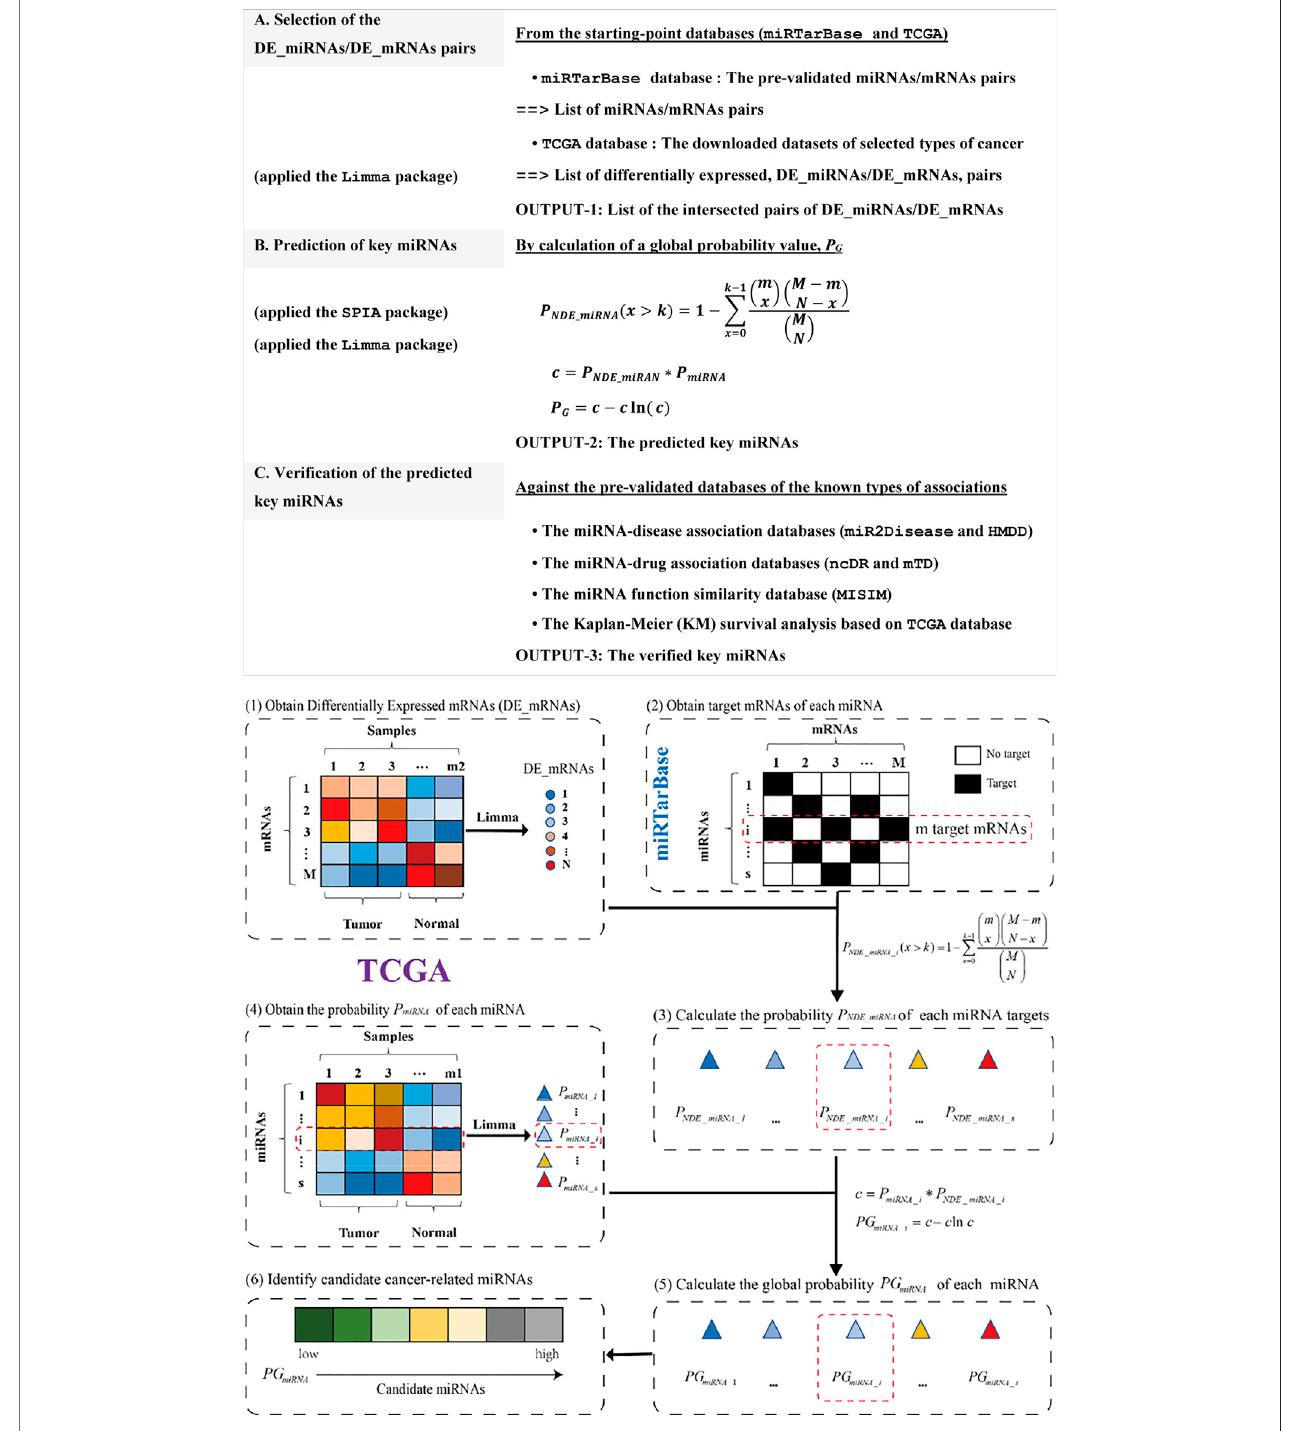
FIGURE 1 | Work fl ow of the MIMRDA method. Multiple steps for predicting and verifying key miRNAs (top-box). Sequential procedures for calculating a global probability P G value (bottom-box). The probability P miRNA is estimated by using the Limma package for DE_miRNAs from a TCGA dataset. The probability P NDE_miRNA is estimated with the formula, which incorporates the expression pro fi les of miRNAs and their target mRNAs from both TCGA dataset and miRTarBase database. The globalprobability P G isadjustedbytheFisher ’ sproductof P NDE_miRNA and P miRNA .Symbols:TotalnumberofDE_mRNAs( N )presentinagivenTCGAdataset;Total numberofmRNAs( M )andthenumberofDE_mRNAs( k ),aswellasthenumberofmRNAs( m )thatarepreciselytargetedbythe i thmiRNA( i beingthecurrentstepinthe iteration) present in the miRTarBase database. See the main text for